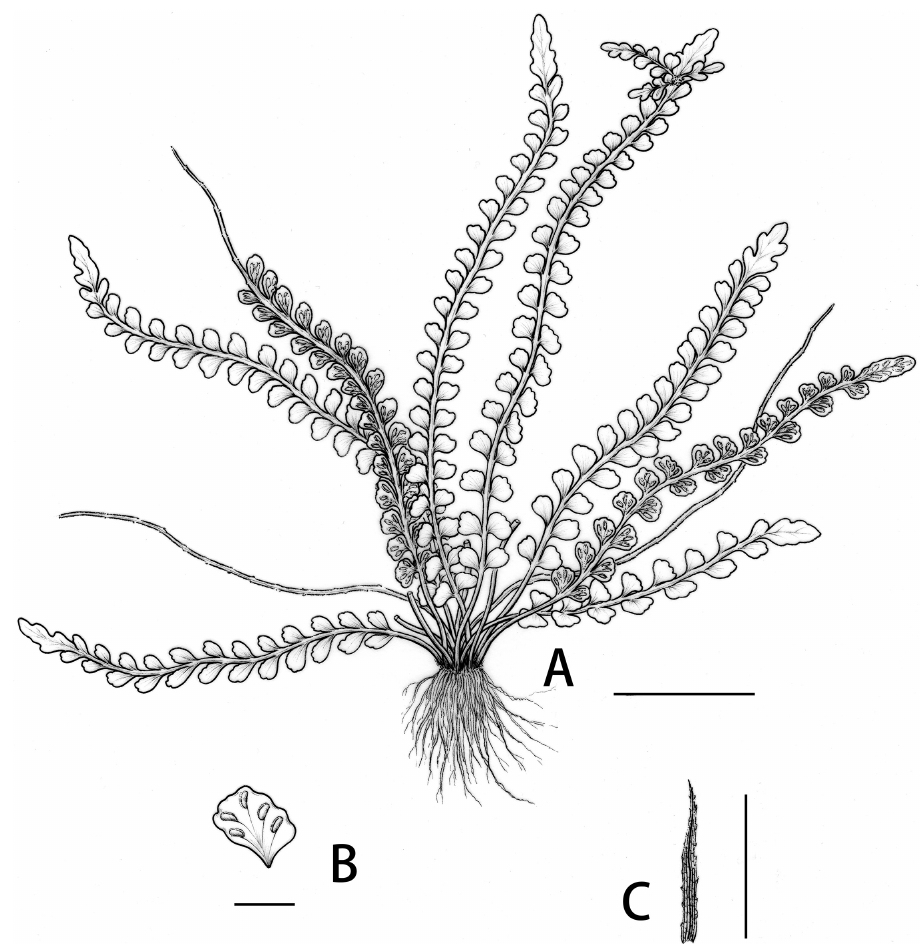
Figure 2. Asplenium jiulianshanense K.W.Xu & G.L.Xu A habit B pinna showing the venation and the distribution of sori C rhizome scale. Scale bars: 2 cm ( A ); 5 mm ( B ); 2 mm ( C